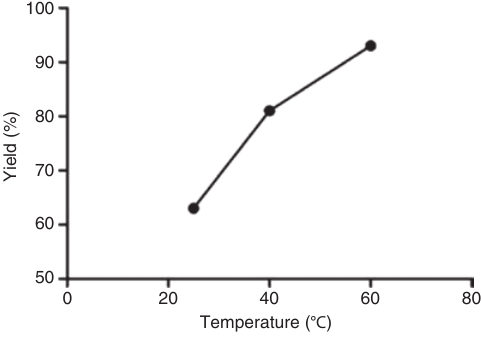
for the proton abstraction of the aldehyde or ketone.